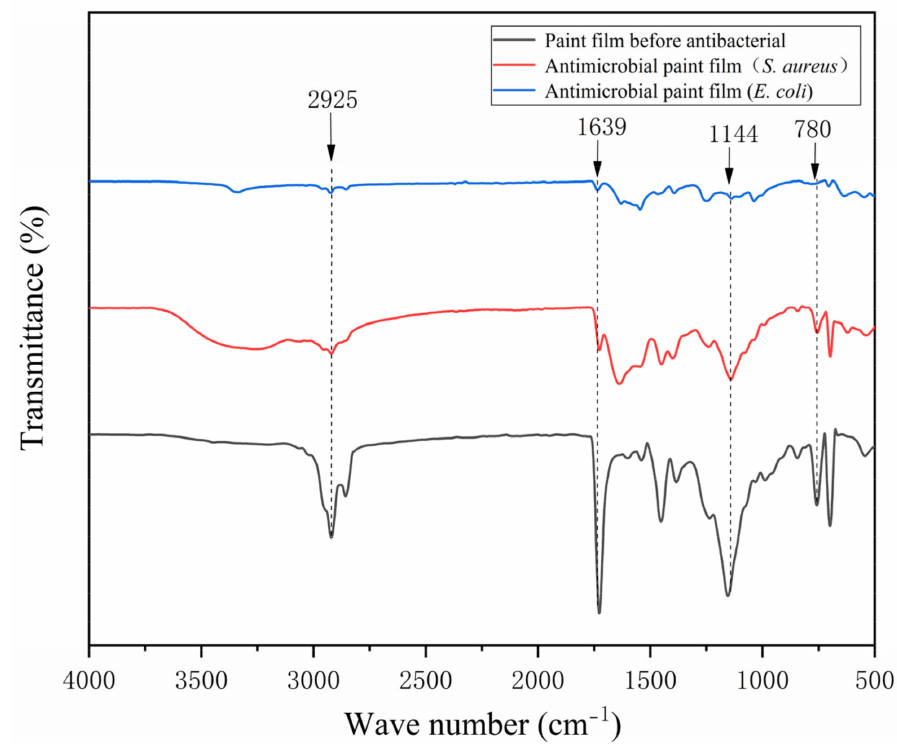
Figure 16. Infrared spectrum of 2 (cid:48) # before and after antibacterial